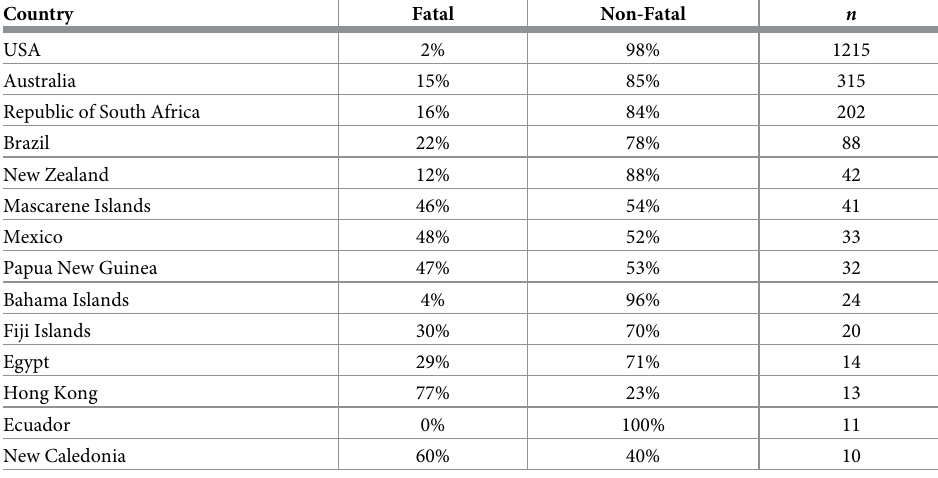
Table 1. Fatal and non-fatal outcomes of shark attacks by country from 1960–2015. Non-fatal outcomes globally represented 85% of attacks. Country Fatal Non-Fatal n USA 2%